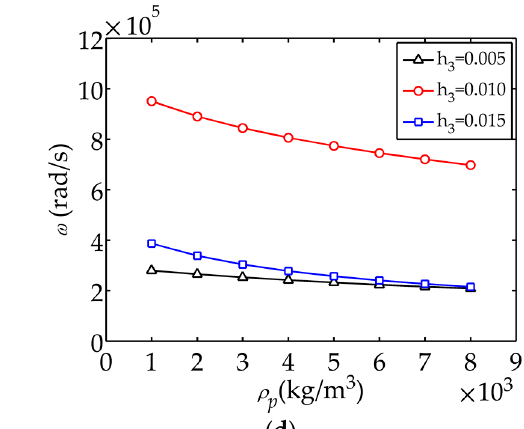
Figure 10. Influence of material parameters on ω : ( a ) C 33 p ; ( b ) e 33 ; ( c ) ε 33 S / ε 0 ; ( d ) ρ